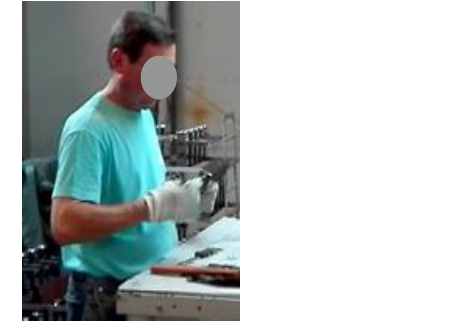
Figure 8 - Dimensional control process Figure 9 - Cleaning and selecting